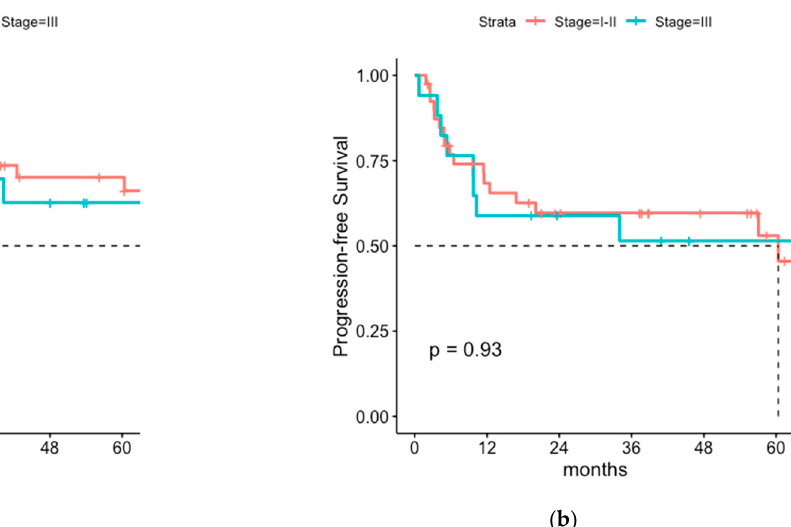
( b ) Figure A3. Stage-adapted ( a ) OS and ( b ) PFS of the subgroup of surgically staged patients only for stage I, stage II, stage ≤ II and stage III, according to AJCC-staging classification (n = 46). References 1.